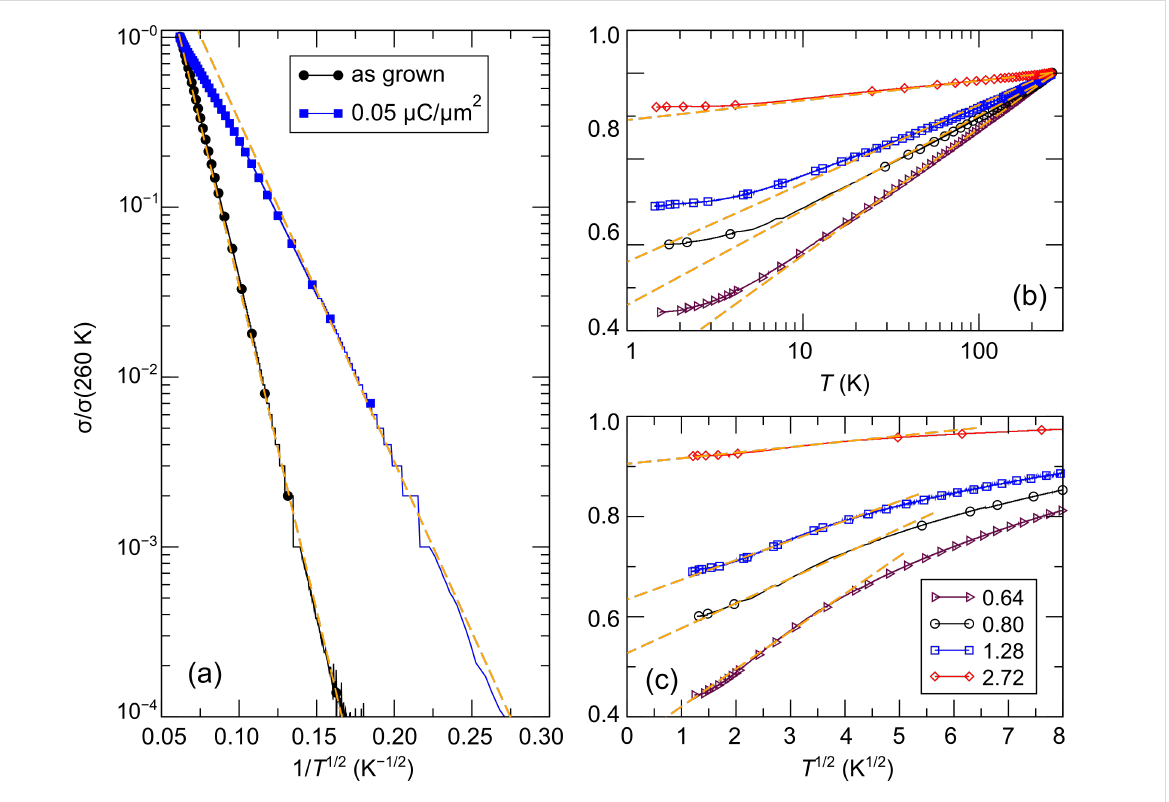
Figure 14: Temperature-dependent conductivity of Pt–C FEBID structures that have been exposed to different post-growth electron irradiation doses as indicated. (a) As-grown briefly irradiated samples show thermally activated behavior following the correlated VRH scenario. (b) Long-term irradi- ated samples reveal a logarithmic temperature dependence of the conductivity in accordance with Equation 27. Saturation of this behavior is observed below about 15 K. (c) Samples in the metallic regime at low temperature show indications for a crossover to a -dependence of the conductivity. The straight dashed orange lines in the plots are meant to facilitate a judgement of the quality of the temperature dependence of the conductivity as predicted by theory. See text for details. Adapted from